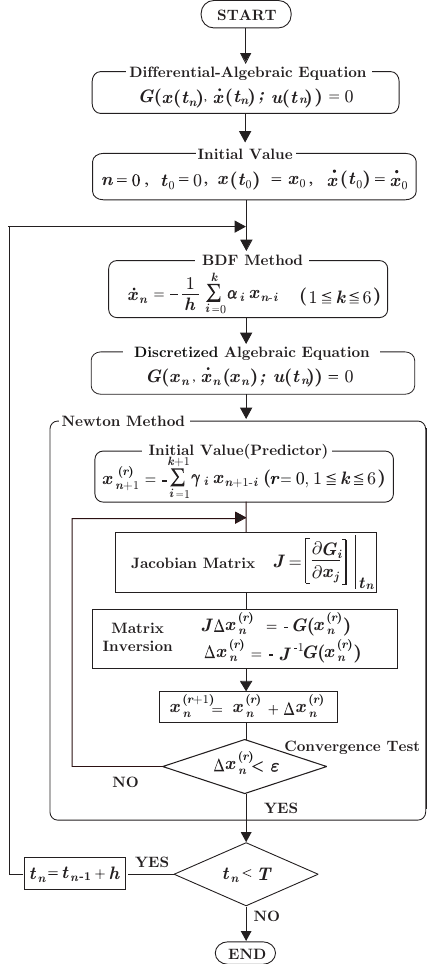
Figure 2. Sparse tableau method.